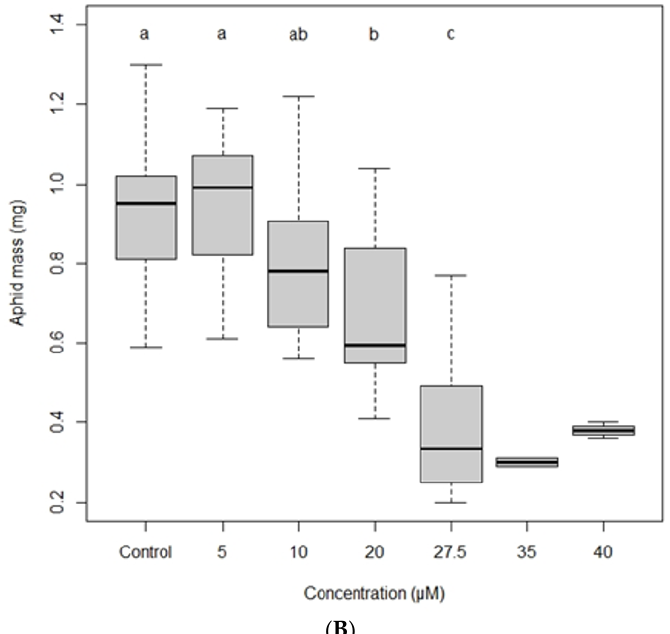
Figure 3. ( A ) Survival curves of the aphid Acyrthosiphon pisum reared on artificial diets containing different concentrations of BCR4 peptide. Mean values of Lethal Time 50 (LT50), in days, are indicated above each curve. ( B ) Mass (mg) of 7-day-old pea aphid Acyrthosiphon pisum subjected to BCR4 treatment. Concentrations labeled with different letters are significantly different ( p < 0.05). The surviving aphid sample sizes of BCR4 at 35 and 40 µM were too small to be statistically meaningful. Table 2. Toxicity of BCR4 peptide on the pea aphid Acyrthosiphon pisum (mean values of Lethal Time 50 (LT50) in days, with confidence intervals), analyzed by survival analysis with a log-normal fit. Concentration (µM)